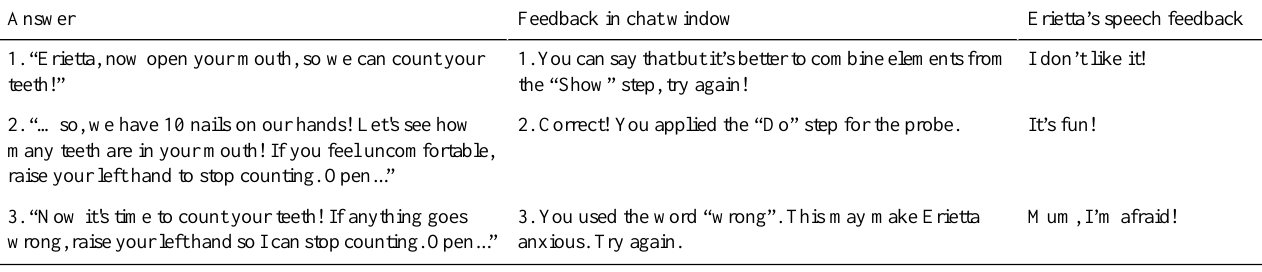
Erietta’s speech feedbackFeedback in chat